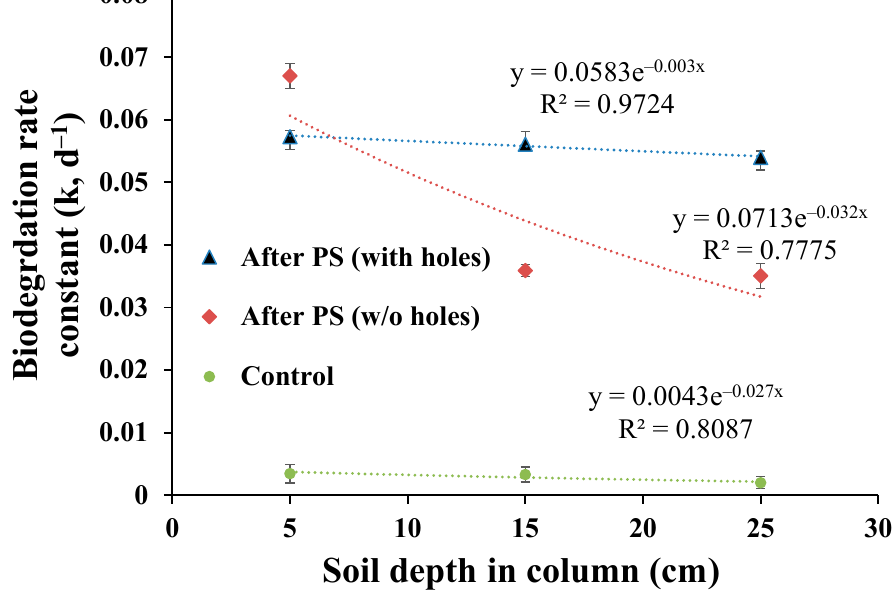
Figure 5. Comparison of the first order biodegradation rates (k, d ‒ 1 ) as a function of soil depth.